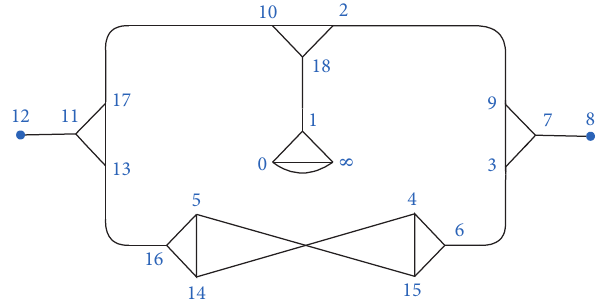
Figure 1: The coset graph of Z